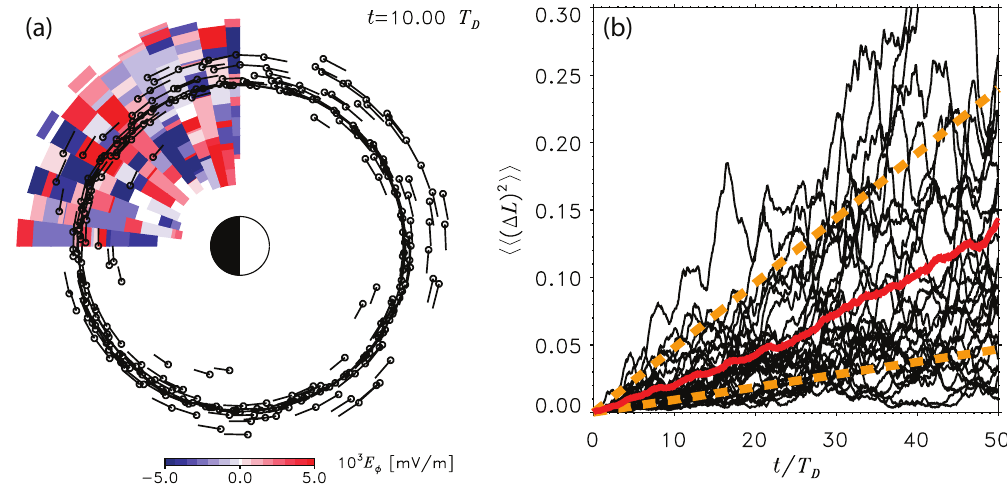
Fig. 5. Panel (a) A snapshot of electron motion in the presence of stormtime Pc5s: E rms ϕ = 2mV/m, m = 50, and 1ϕ = π/ 2 . Panel (b) Radial transport in 30 statistically similar realizations of electron motion (black lines), analytical estimates of the upper and lower limits of radial diffusion (yellow line). Radial transport averaged over all realizations (red